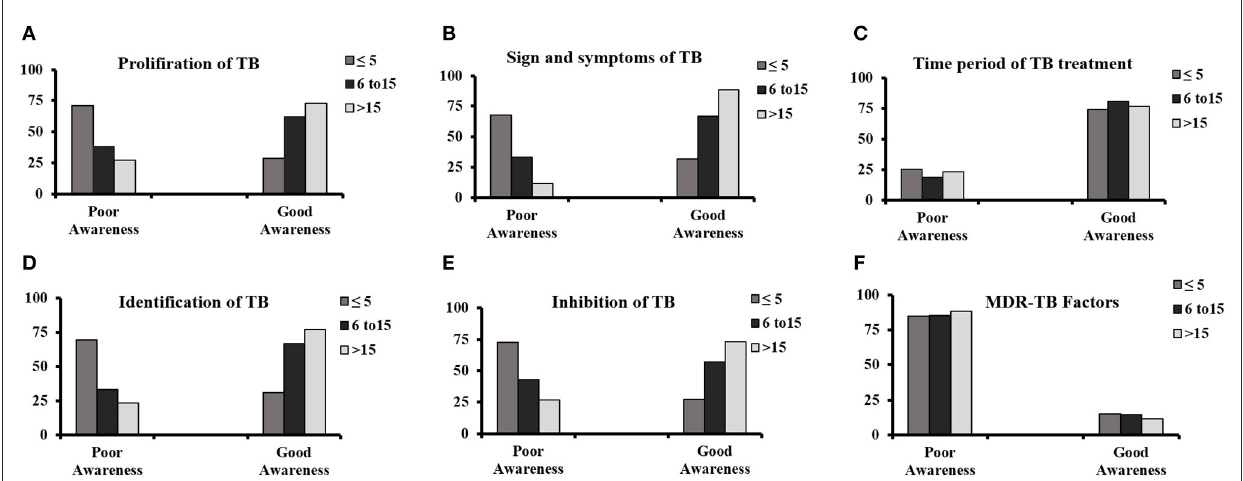
FIGURE3 Correlation of respondent’s working experience in pharmacies with TB awareness regarding (A) proliferation of TB, (B) signs and symptoms, (C) time period of TB treatment, (D) identification of patients with TB, (E) inhibition of TB, and (F) multidrug-resistant TB